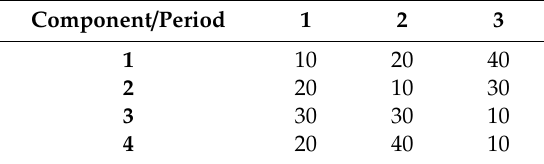
Table 2. Demand sizes for components ( d jt